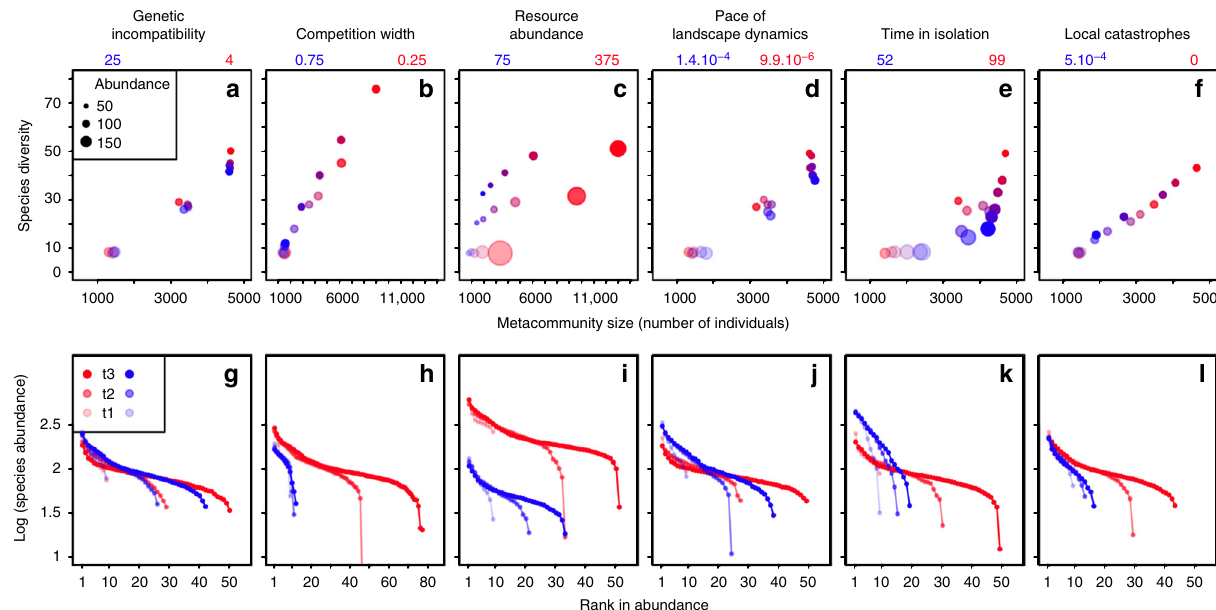
Fig. 4 Effect of biotic and abiotic factors on the evolutionary emergence of macroecological patterns. a – f Relationship between species diversity and metacommunity size. g – l Species rank-abundance distributions. For each biotic and abiotic factor, the median values of the macroecological variables of interest (over 50 simulation replicates) are shown at different stages of diversi fi cation: at the end of stage 1 (light color), mid-way through stage 2 (medium), and at a stationary state (dark). Factor values are scaled from blue (leading to the lowest stationary species diversity) to red (leading to the highest stationary species diversity), with the corresponding values indicated above each column. Other parameter values as in Supplementary Table 1. In a – f the size of dots is proportional to the median value of species abundances. See text and Methods for the de fi nition of each